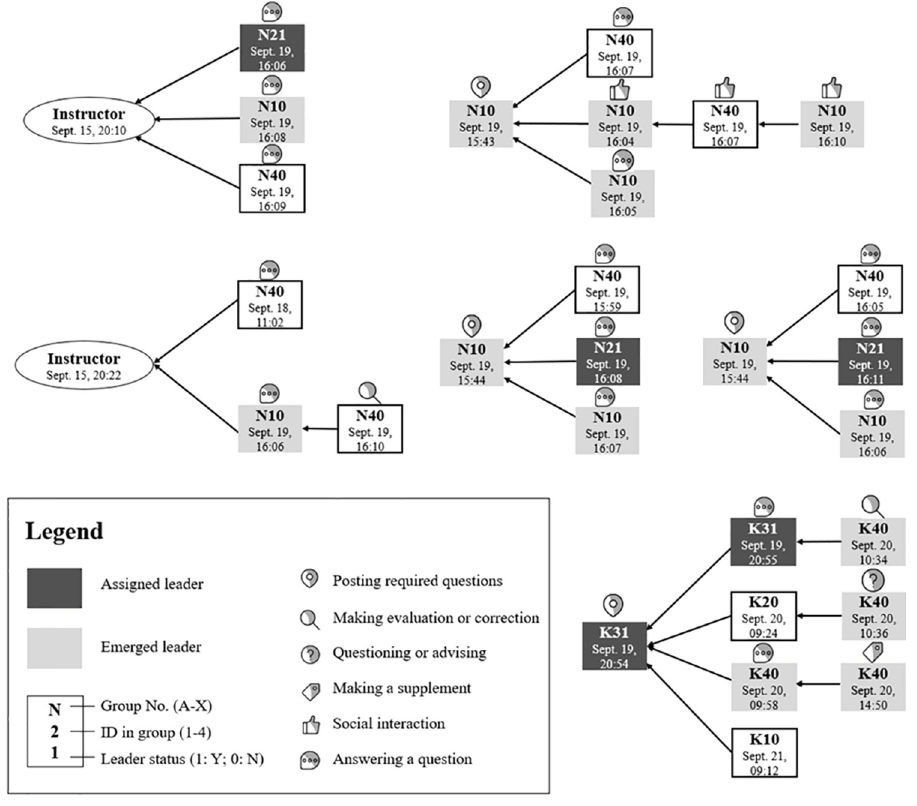
Fig 6. Visualization chart showing assigned and emerged leadership based on